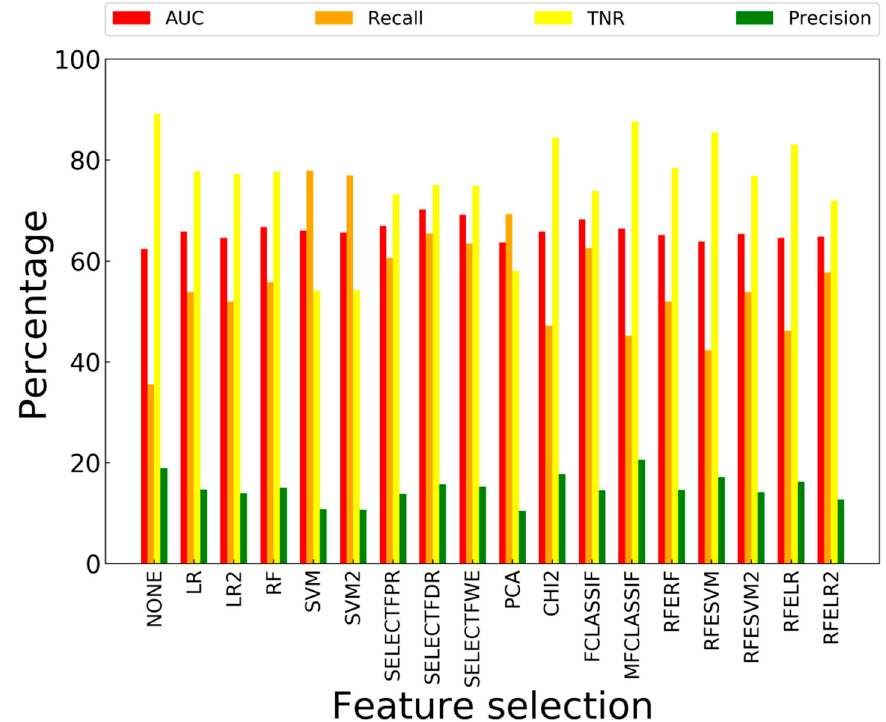
Figure 11. Classification results with the highest AUC in each feature selection on balanced data.